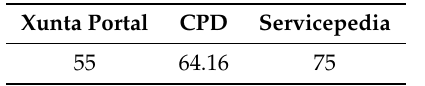
Table 4. Average SUS result by